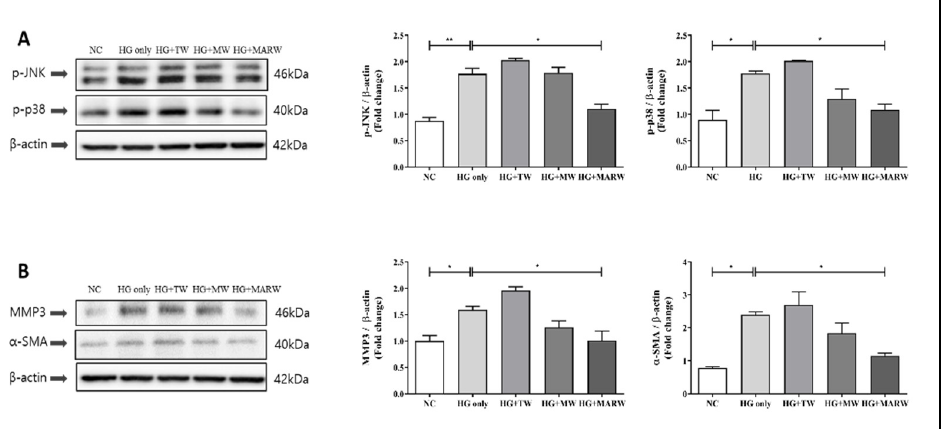
Figure 4. Effects of MARW on MAPK and the pathway that leads to fibrosis in HG-induced HK-2 cells. HK-2 cells were induced with glucose (71.68 mM) for 24 h and were treated with 10% TW, MW and MARW. ( A ) MAPK (p-JNK and p-p38) pathway along with ( B ) fibrosis-linked ( α -SMA and MMP3) proteins were analyzed. * p < 0.05, and ** p < 0.01 represent significant differences based on Tukey’s ANOVA test. Values represent the mean ± SEM. Abbreviations: NC, normal control; TW, tap water; MW, mineral water; HG, high glucose; MARW, magnesium-enhanced alkaline-re- duced water; MAPK, mitogen-activated protein kinase; α -SMA, alpha-smooth muscle actin; MMP3, matrix metalloproteinase 3; p-JNK, p-jun N-terminal kinase.